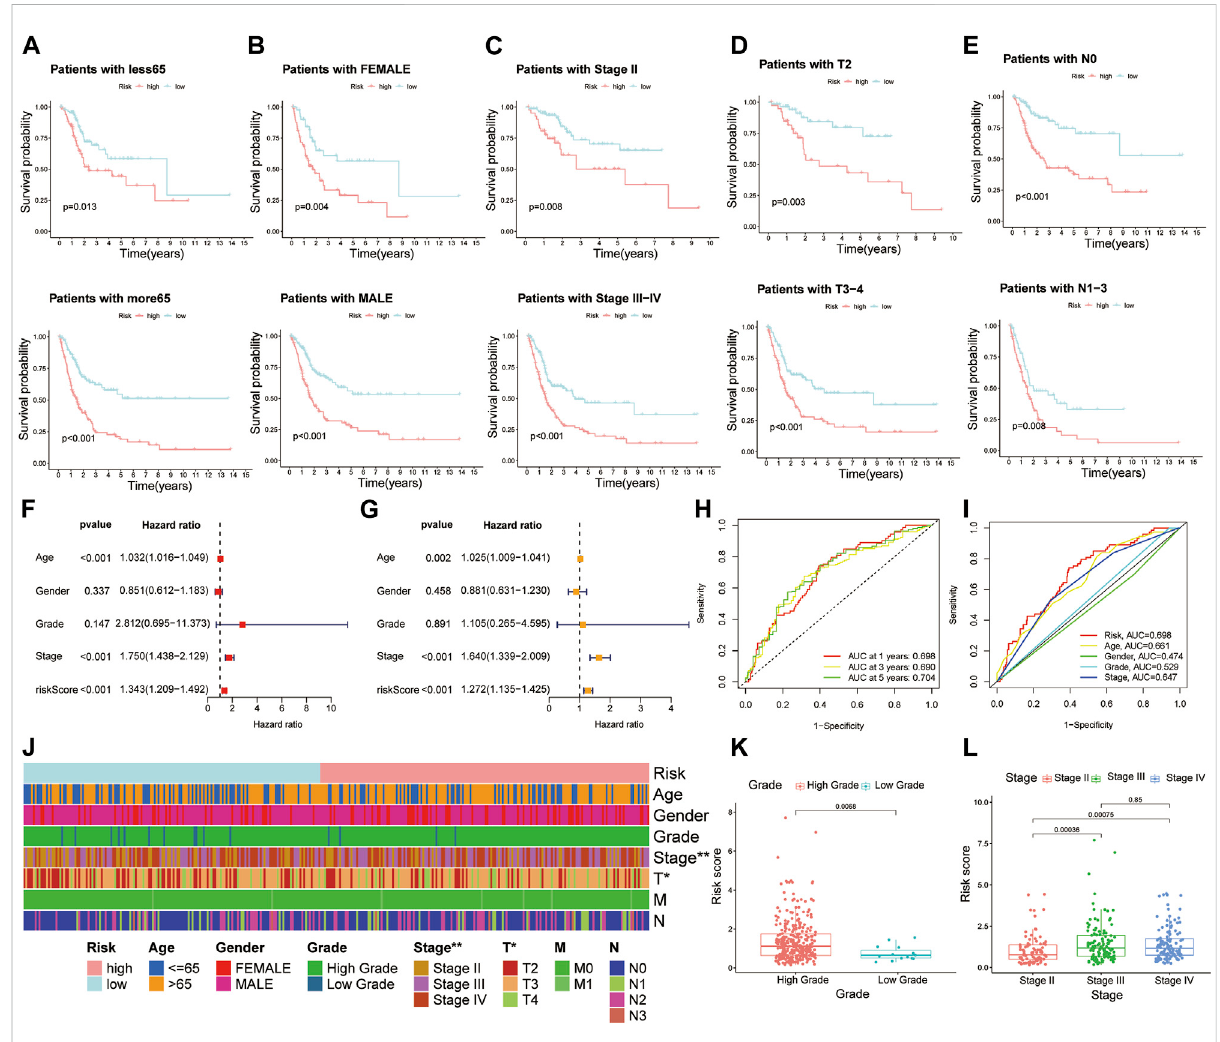
FIGURE 4 Further con fi rmation of prognostic value of the risk model combined with clinical features. Kaplan – Meier survival curves of high- and low-risk groupsamongmuscle-invasivebladdercancer (MIBC)patients sortedbasedon differentclinicalfeatures, including (A) age, (B) gender, (C) stage, (D) T stage, and (E) N stage. (F,G) Risk model was an independent factor of prognosis by using univariate Cox and multivariate Cox proportional hazard regressionanalyses. (H) The1-,2-,and3-year receiver operatingcharacteristics(ROC) curvesofall MIBC patients. (I) The 1-yearROC curves of risk score and other clinical features. (J) The heat map of distinctions in clinical features between high- and low-risk groups. (K,L) The histogram showing the difference of risk scores in MIBC patients strati fi ed by grade and stage. * p < 0.05, ** p <